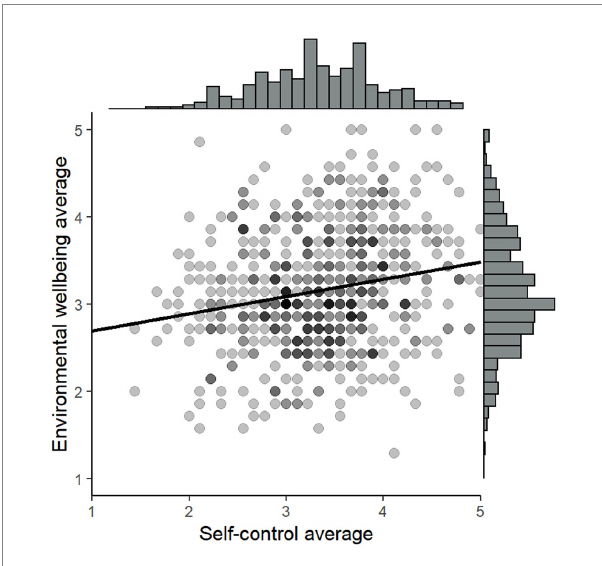
FIGURE 1 Scatterplot of the correlation between environmental wellbeing and self-control. The y -axis shows the average of the environmental wellbeing scale and the x -axis shows the respondents’